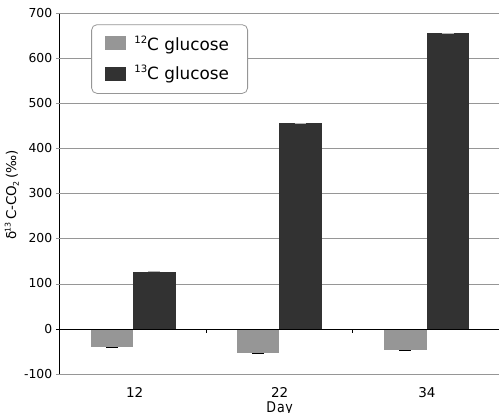
Figure 4. Kinetic of the δ 13 C-CO 2 released from an irradiated and autoclaved (4h) soil inoculated with 13 C-labeled glucose ( 13 C glu- cose) or with unlabeled glucose ( 12 C glucose) through 34 days of incubation. Standard deviation was estimated using three replicates per treatment ( n =